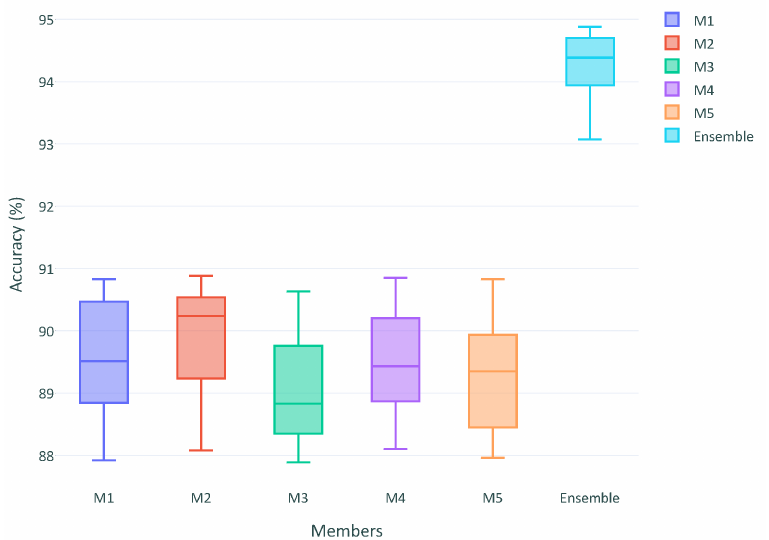
Figure 5. Box-plot showing Bayesian single model accuracy vs. accuracy of ensembles